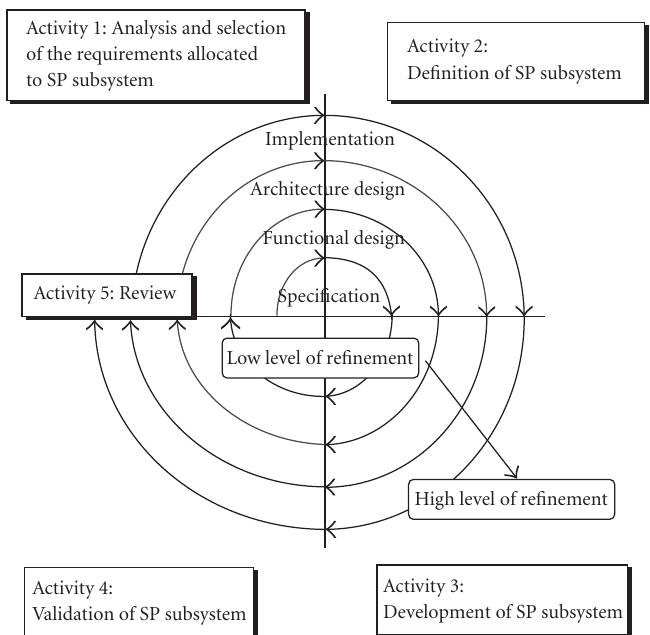
Figure 3: Spiral view of the development